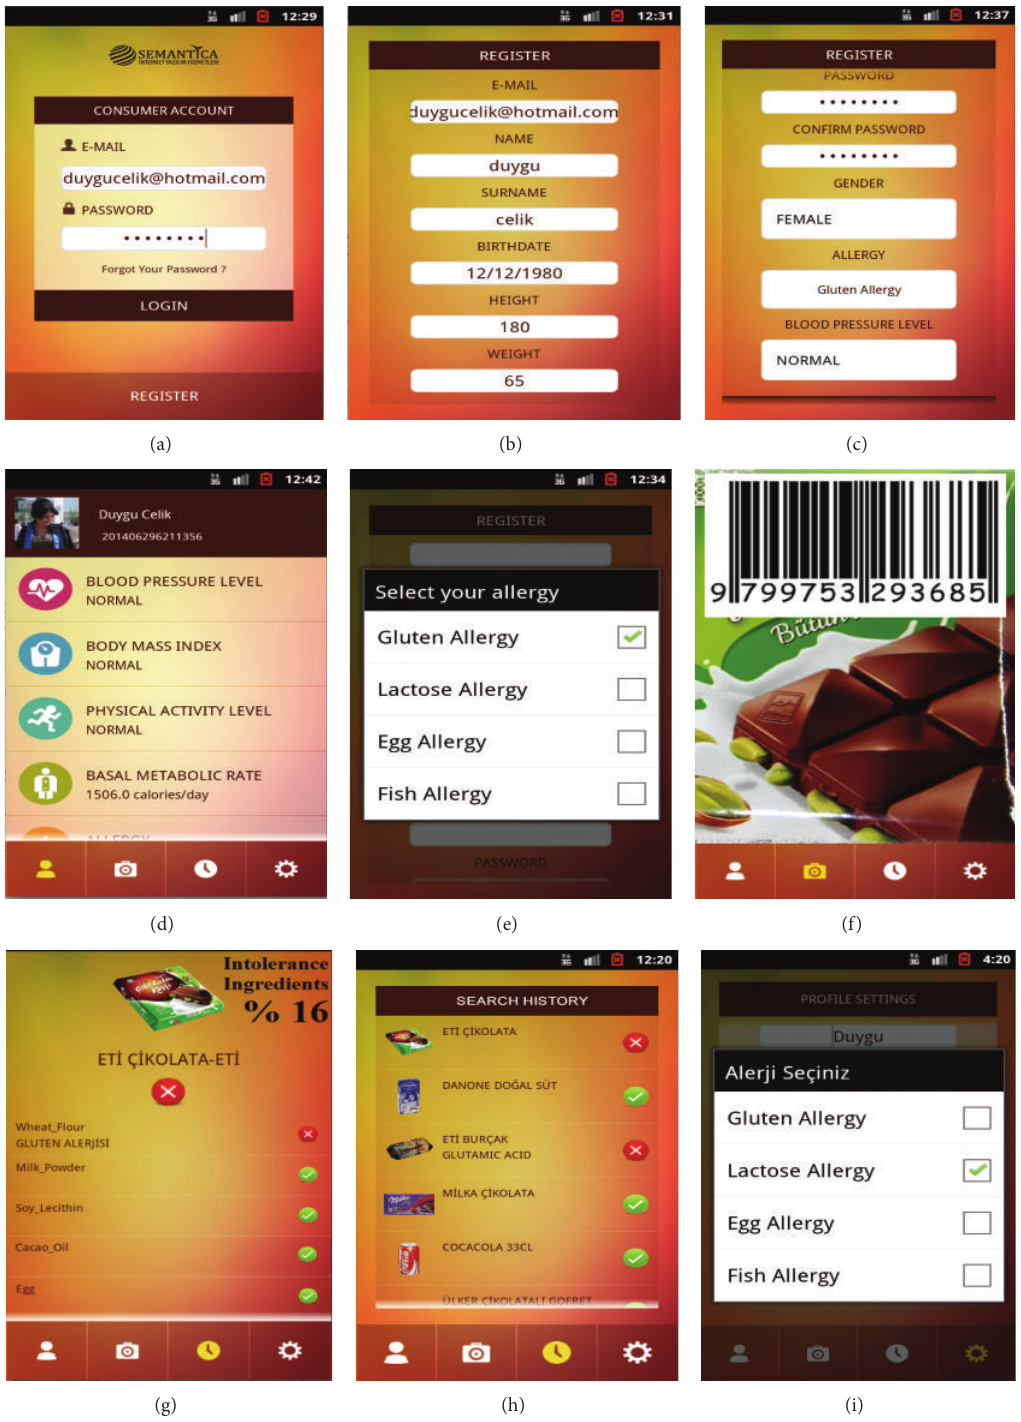
Figure 8: The customer member chooses various products and gets the results on the android mobile application of the system though FOKB. health condition (food allergy, heart disease, hypertension, cholesterol, diabetes, etc.) through the SWRL rule set of the FOKB. After that, the system will return any intolerance reasons found through the SWRL rules and the score of the product after CME matching according to the food nutrients sensitivity of the